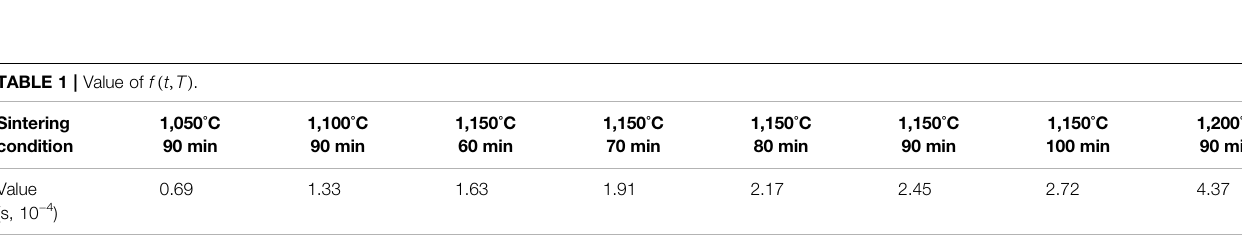
FIGURE 7 | Effect of sintering condition on tensile strength of sintered Fe-2Cu-0.8C-0.6Mo-2W samples. (A) sintering temperature; (B) sintering time.